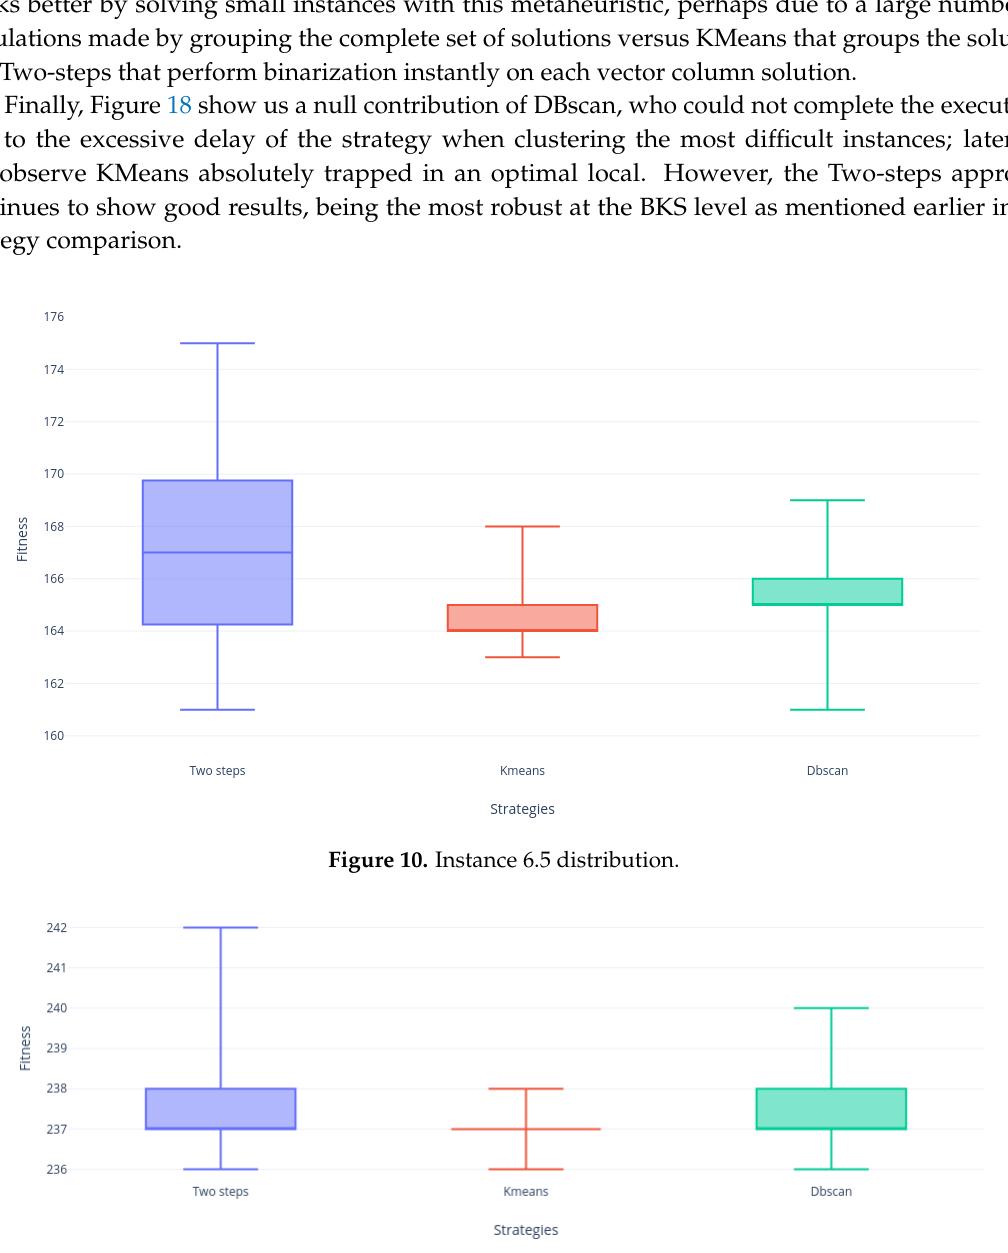
Figure 11. Instance a.5